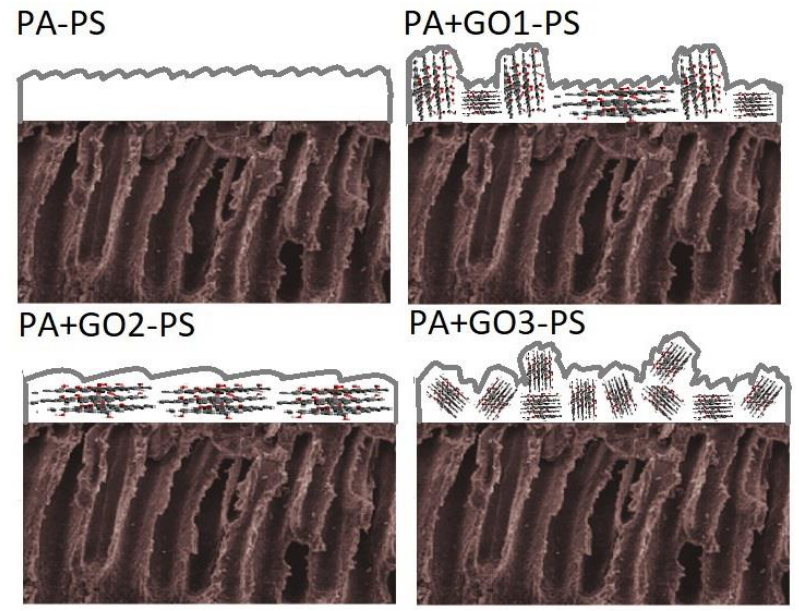
Scheme 1. Graphical representation of GO sheets in the polyamide layer of the modified membrane.